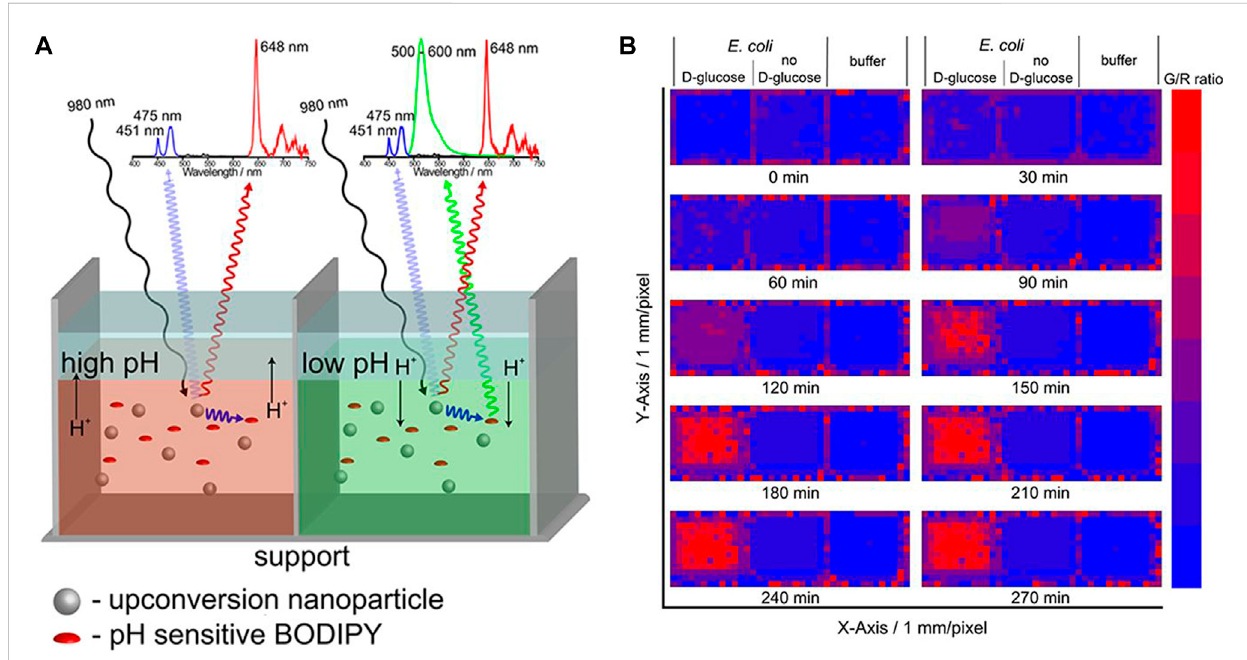
FIGURE 9 (A) Simple self-referenced luminescent pH sensors based on up-conversion nanocrystals and pH-sensitive fl uorescent BODIPY dyes. (B) Time- dependent changes of the G/R ratio of the pH sensor layers treated with a suspension of E. coli with D-glucose and a suspension of E. coli without D-glucose or pure buffer. [Reprinted with permission from Ref. (Radunz et al., 2019) Copyright 2019: American Chemical